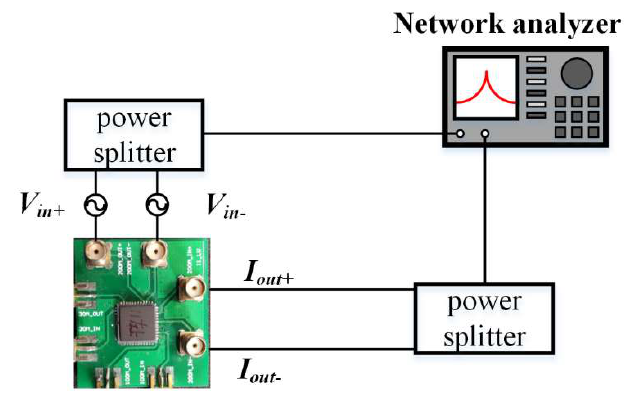
Figure 7. Measurements of S -parameters of the fabricated TPoS resonators in a four-port DIDO configuration. Schematic diagram of the electric measurement platform. The proposed resonator was connected to a network analyzer to measure its transmission S 21 at the resonant frequency of 206 MHz with a 20 MHz span.